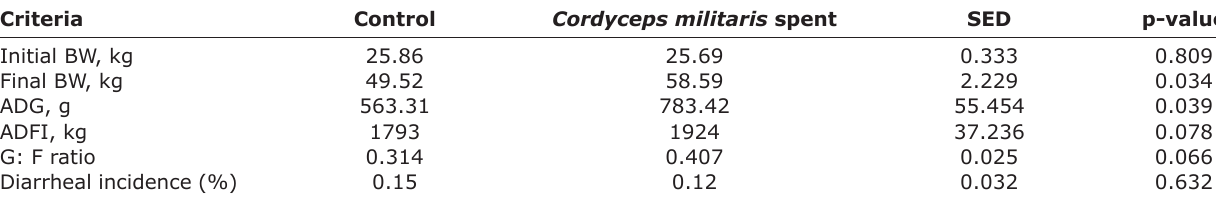
Table-3: Growth performance and diarrheal incidence in growing pigs fed Cordyceps militaris spent mushroom substrate 1 . Criteria